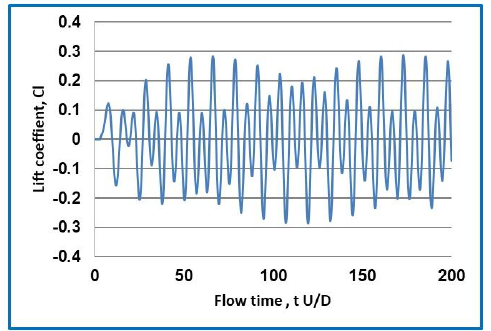
Figure 10: Lift coeflcient history at f v = f s , crossflow vibration